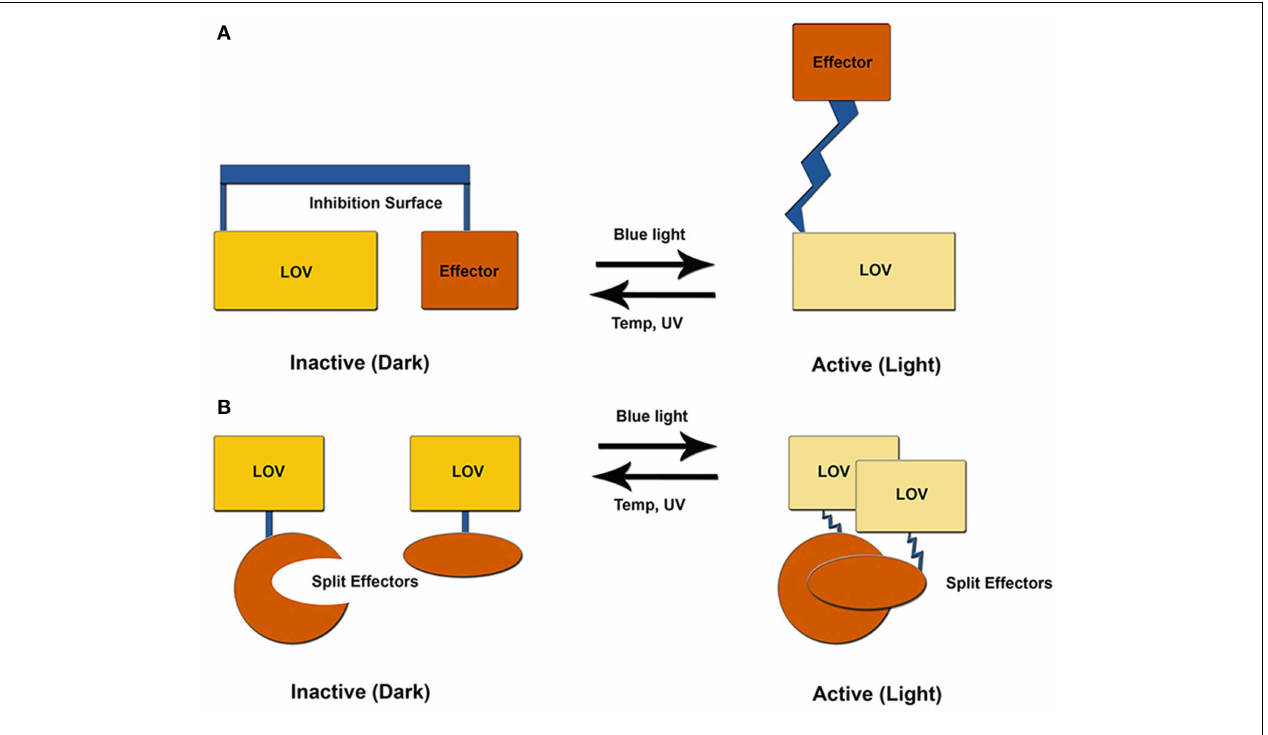
photoexcitation. (B) An effector molecule is split into two inactive components. Light activation induces LOV-mediated dimer formation to activate the effector